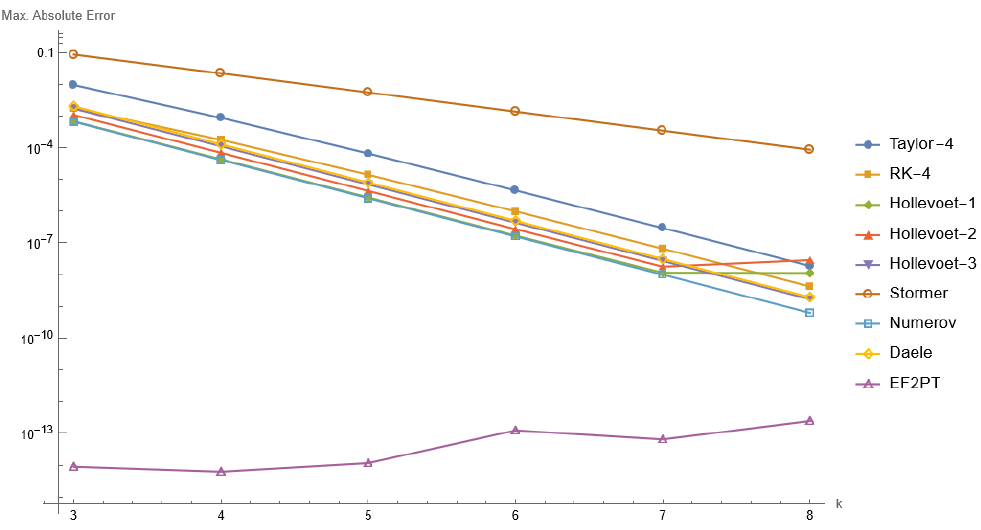
Figure 2. Maximum absolute errors for Problem 1 as a function of the stepsize h = 2 − k π , k = 3 ( 1 )